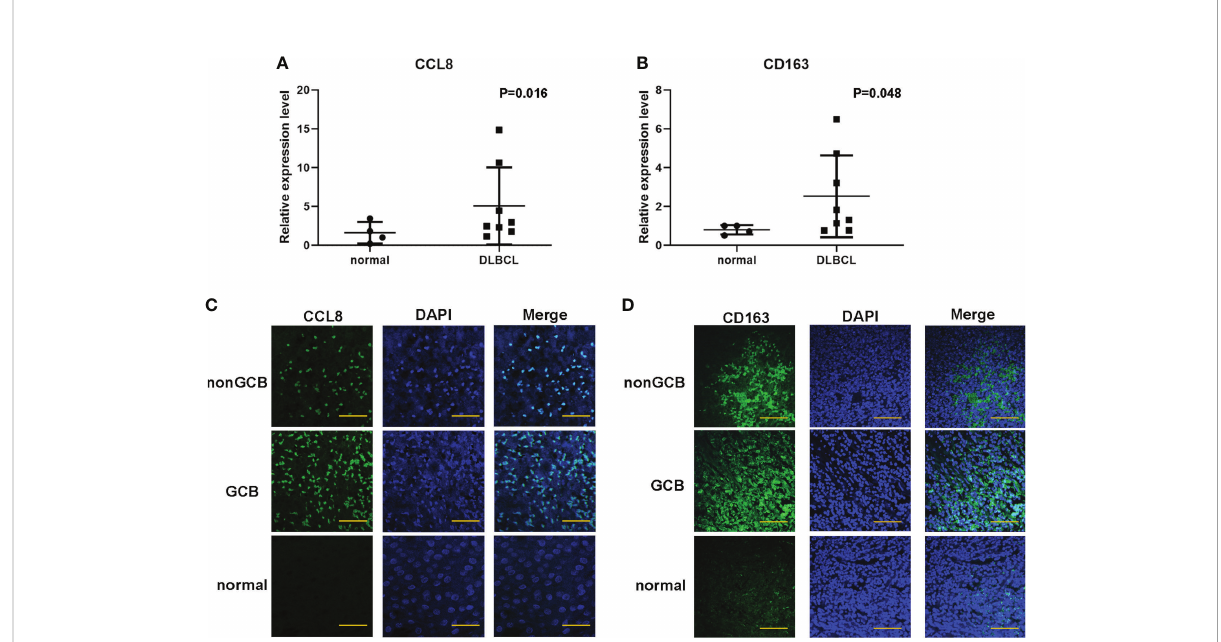
FIGURE 6 Validation of the expression of CCL8 and CD163 levels in DLBCL tissues and paracancer tissues. (A, B) q-PCR analysis for the mRNA expression of CCL8 and CD163 in DLBCL tissues and paracancer tissues. Statistical test was the multiple t test. (C, D) Tissue immuno fl uorescence imaging analysis to detect the amounts of CCL8 and CD163 in paraf fi n sections. Scale bars: 100 m